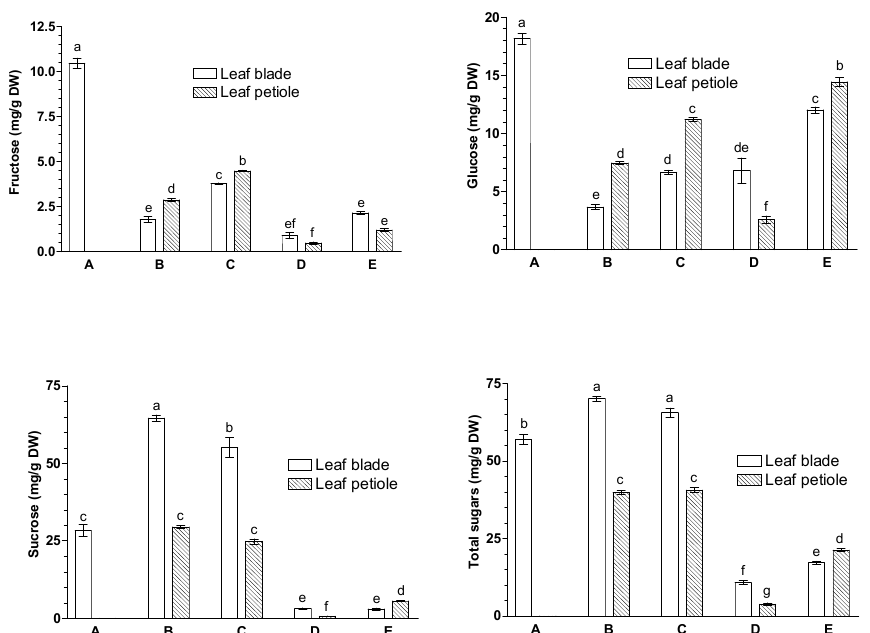
Figure 3. Effects of methyl jasmonate (JA-Me) applied to the adaxial and abaxial sides of leaf blade on the contents (mg/g DW) of sugars in leaf blades and petioles of G. biloba . Mean results ± SD followed by the same letter were not significantly different ( p < 0.05) according to Tukey’s test. A—initial stage, leaf samples collected on 9 September; B—control (lanoline), leaf samples collected on 30 September; C—JA-Me applied to the adaxial side, leaf samples collected on 30 September; D—JA-Me applied to the abaxial side, leaf samples collected on 30 September; E—naturally senesced leaf, samples collected on 20 October.